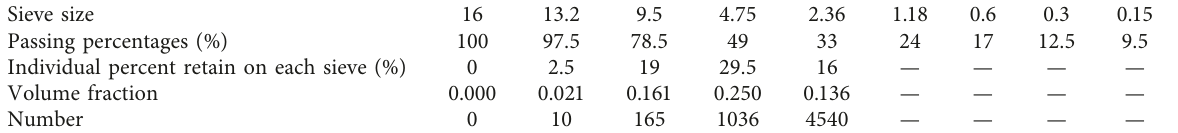
Table 3: Aggregate particles of the asphalt mixture of AC-13.